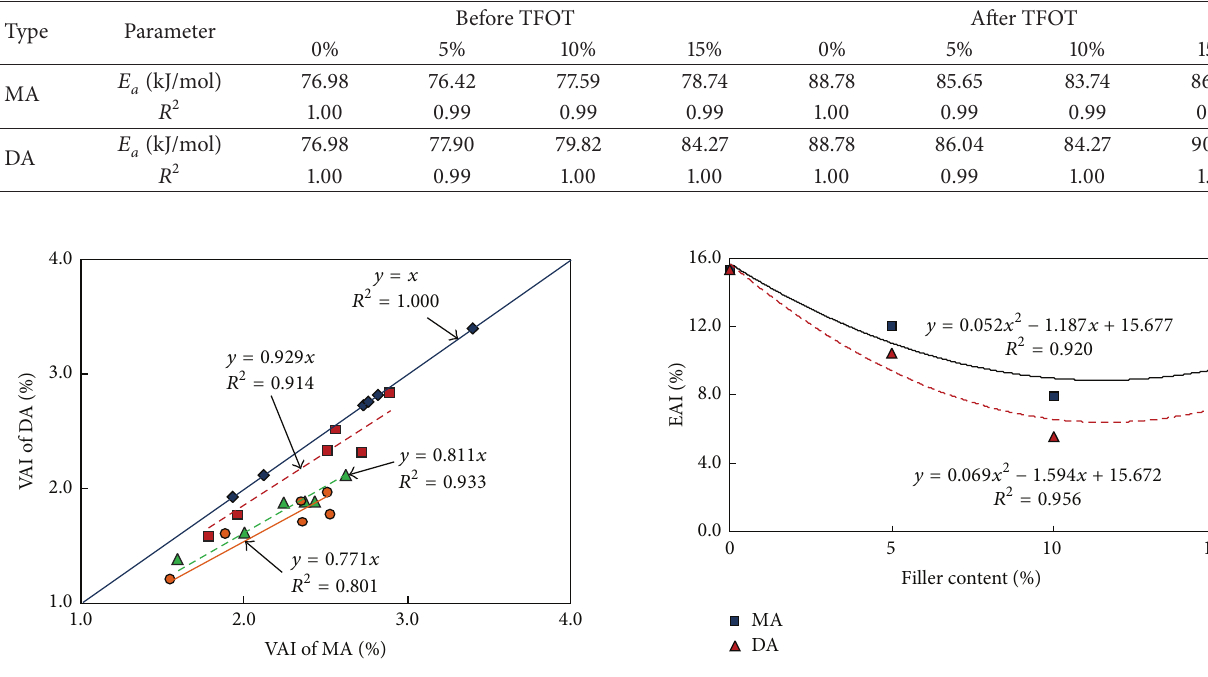
Figure 14: EAIs of asphalt mastics versus content after